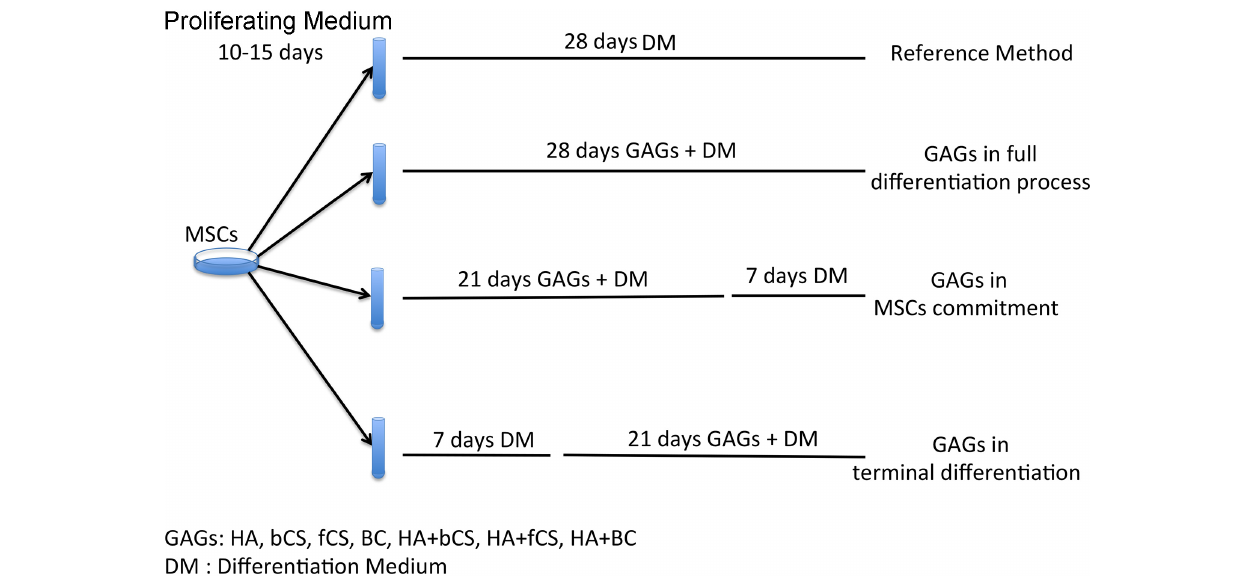
FIGURE 1 | Experimental plan. MSCs were expanded for 10–15 days in a PM. Then we induced chondrocyte differentiation with four different protocols. The reference method was a procedure with a differentiation medium (DM) containing differentiating factors. The other three methods were based on DM supplemented with GAGs at different time points during the differentiation